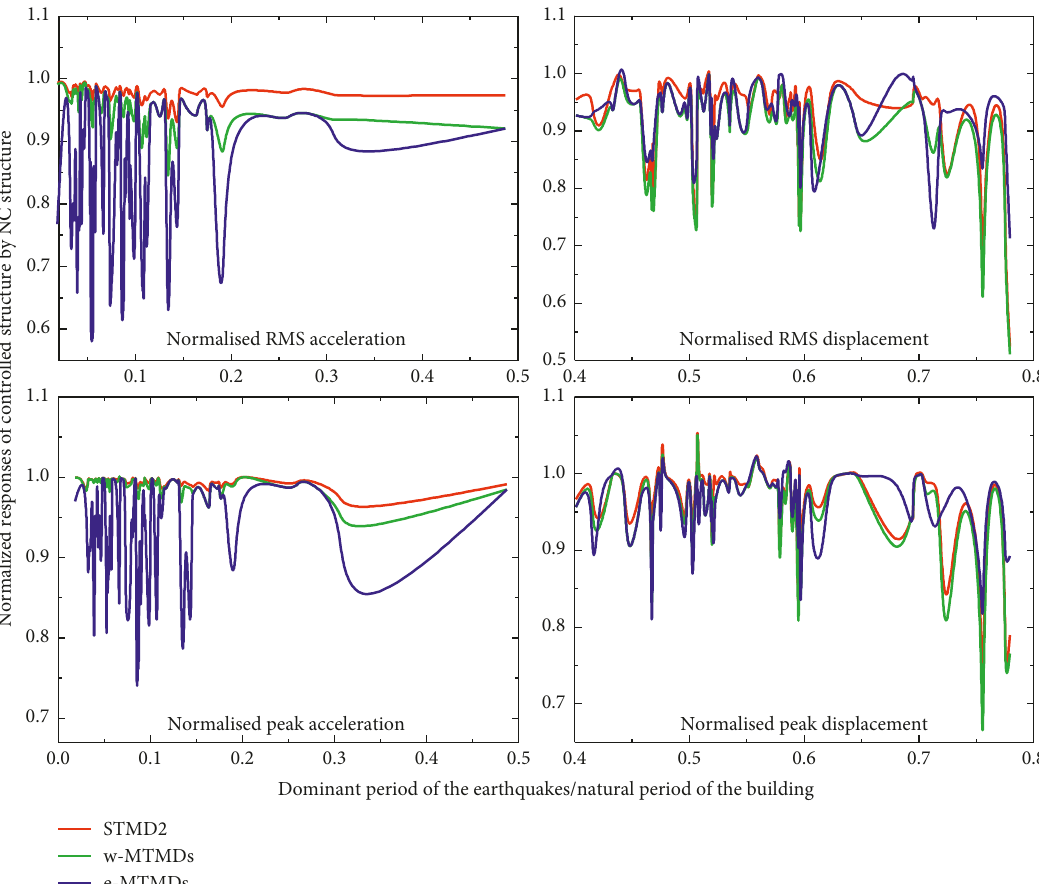
Figure 5: The variation of responses for the NC, STMD, w-MTMDs, and e-MTMDs subjected to earthquake